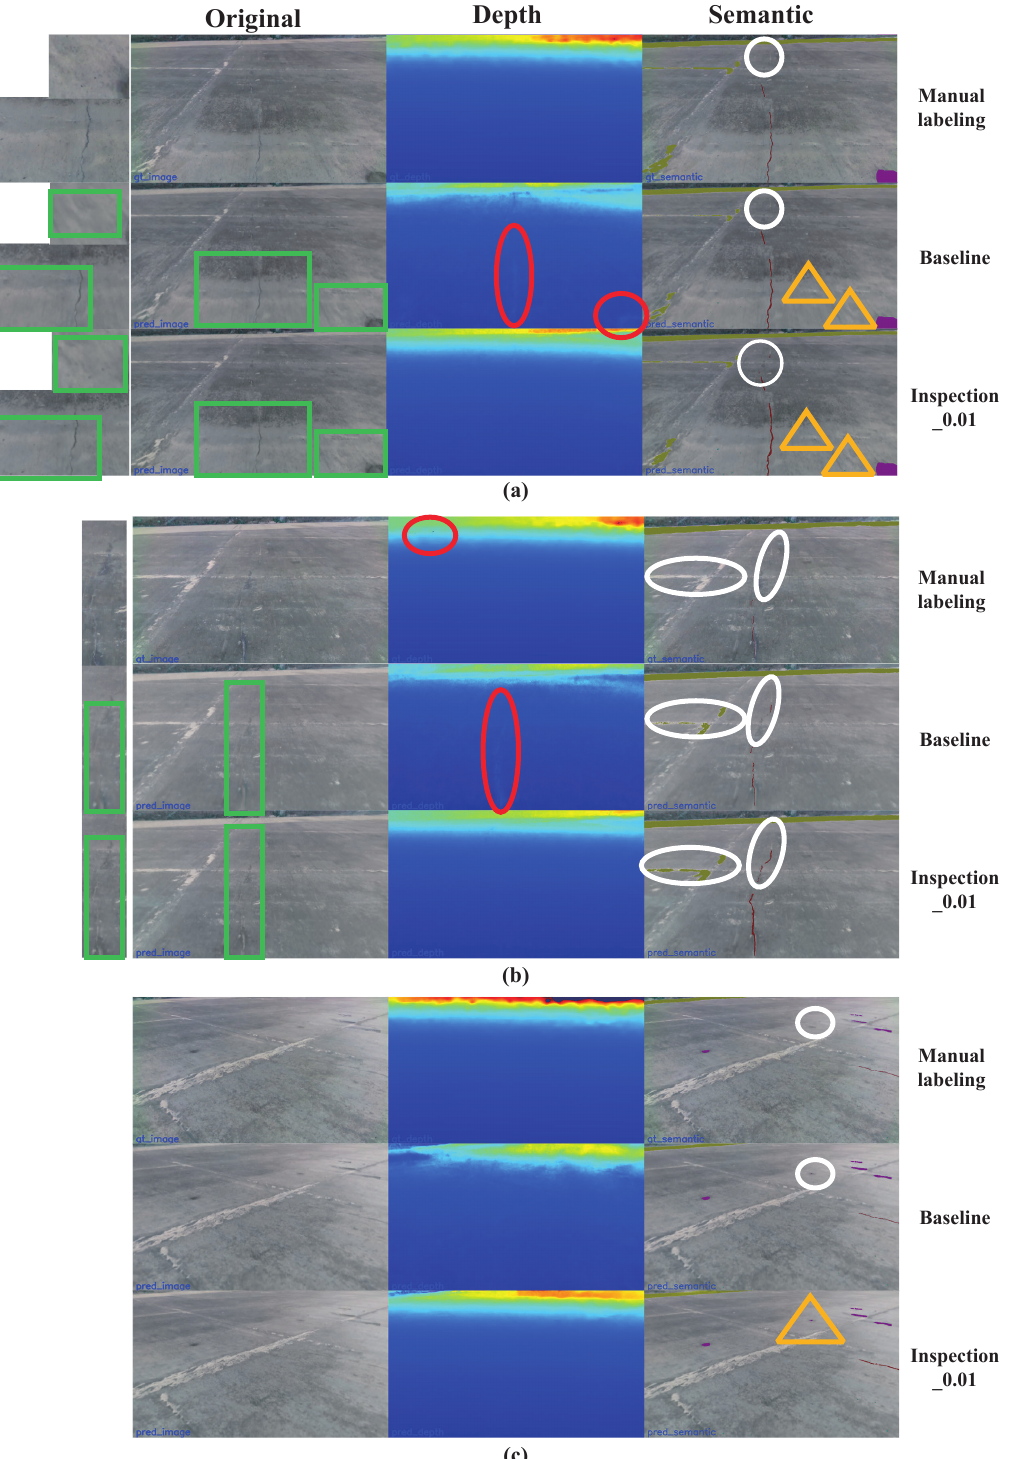
Figure 9. Multi-type rendering results comparison with manual labeling of validation data. ( a – c ) depict the rendered image results from different viewpoints. The green box marks the comparison of the original image rendering. The red ellipse marks the comparison of the depth rendering. The white circle marks that the Nerf models can recover further semantic information than manual labeling. The orange triangle marks the comparison of the semantic rendering results of different